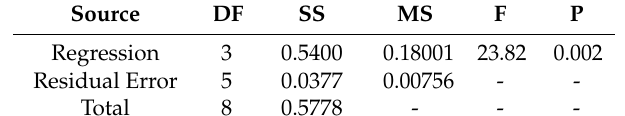
Table 12. Analysis of variance.